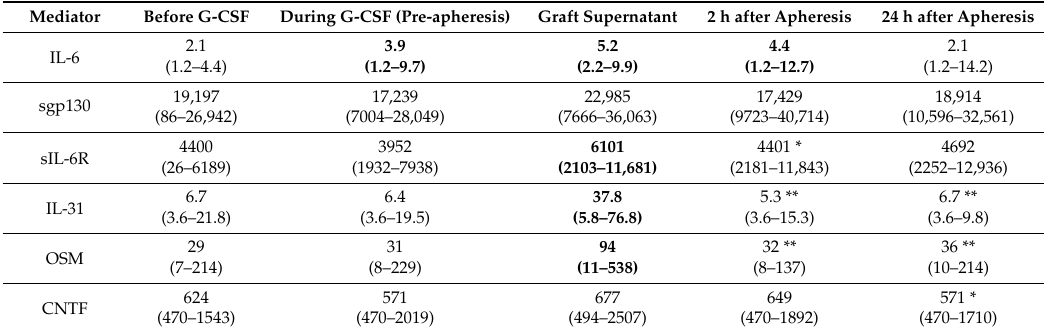
Table 2. Serum levels of IL-6 family cytokines at four different time points during stem cell mobilization and harvesting; the levels in graft supernatants are also included as a comparison. The results for 20 healthy stem cell donors (median age 51 years, range 25–73 years) are summarized, and all the results are presented as the median level and the variation range. All concentrations are given as pg/mL, and statistically significant alterations compared with the pretherapy levels (before G-CSF therapy) are marked in bold (Mann–Whitney U test). Graft levels were only available for 19 patients, and statistically significant differences between graft levels and postapheresis levels are indicated in the table (* p < 0.05, ** p <